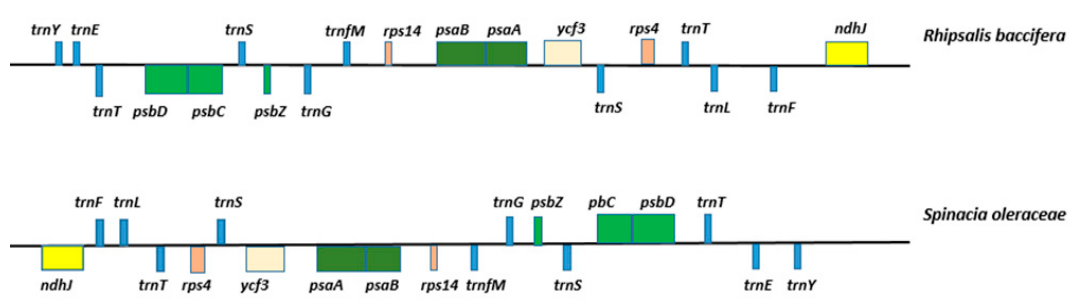
Figure 3. Structural alignment of the LSC region between genes ndhJ- trnY. Figure showing inversion in the cp genome of R. baccifera relative to Spinacia oleraceae.